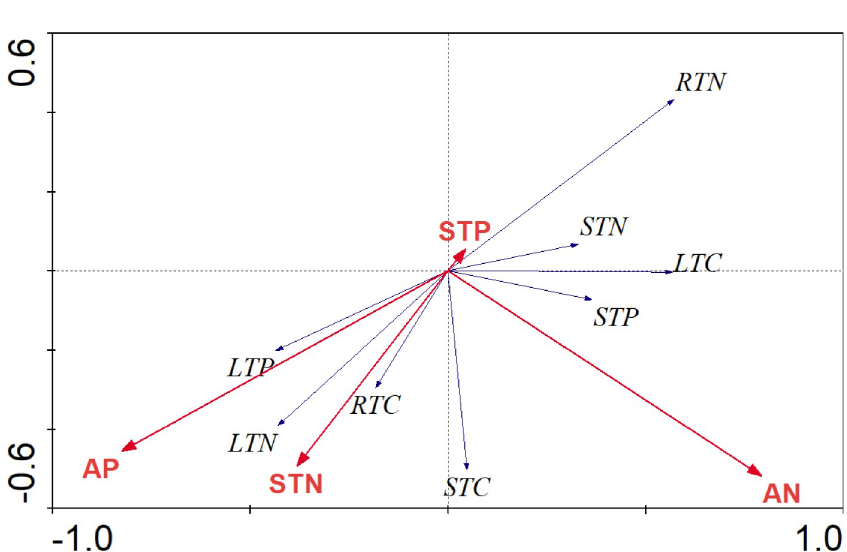
Fig 6. Redundancy Analysis (RDA) result that showed the relationship between soil ecological stoichiometric characteristics and nutrients in various plants organs. The red arrow shows soil ecological stoichiometric characteristics and the blue arrow shows the nutrients concentration in various organs. In the Box plot, LTC, leaf total carbon, LTN, leaf total nitrogen, LTP, leaf total phosphorus, RTC, root total carbon, RTN, root total nitrogen, RTP, root total phosphorus, STC, stem total carbon, STN, stem total nitrogen, STP, stem total phosphorus, EC, electrical conductivity, pH, pH values, SMC, soil moisture contents, BD, bulk density, AN, available nitrogen, AP, available